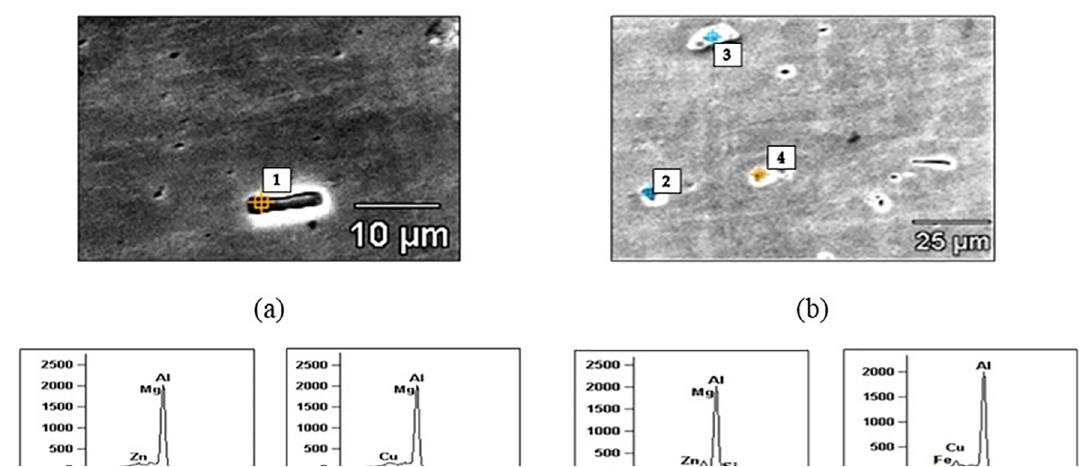
Figure 4. Microstructural aspect of weld metals in the condition as welded. (a) GTAW; (b) FSW. Behara's etching. Table 7. Semi-quantitative chemical analysis determined by EDS of points identified by arrows in Figure 4(a) (wt%). Points